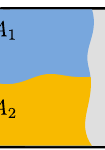
FIG. 1. Schematic representation of the system under study. The goal here is to investigate the typical amount of entangle- ment between A 1 and A 2 , which are in a random mixed state due to coupling to subsystem B . The global state of the system A ∪ B is obtained from an ensemble of random pure (Page) states. In this setup, there is no notion of locality.